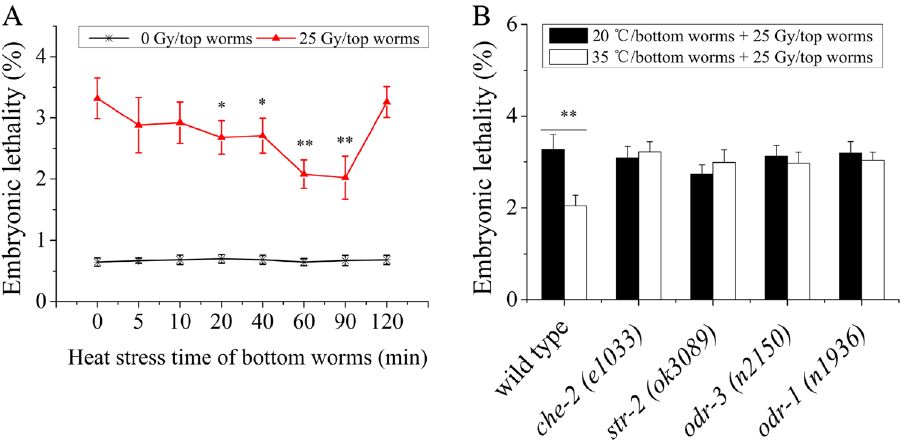
Figure 1. Heat-stressed bottom worms can induce RAR of embryonic lethality in top worms via the volatile stress signals. ( A ) The change of embryo lethality of top worms after coculture with bottom worms subjected to 35 °C heat exposure; ( B ) Embryonic lethality of top worms whose sensory nerve function is absent ( che-2, str-2, odr-3, and odr-1 ) after coculture with the bottom worms (N2). Results are means ± SD (n = 5, * P < 0.05, ** P <